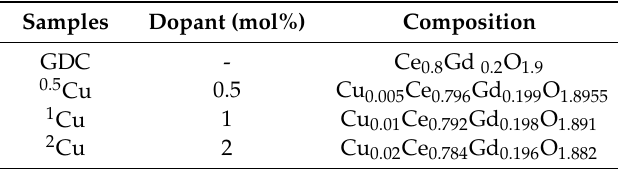
Table 1. Composition of electrolyte powders prepared.